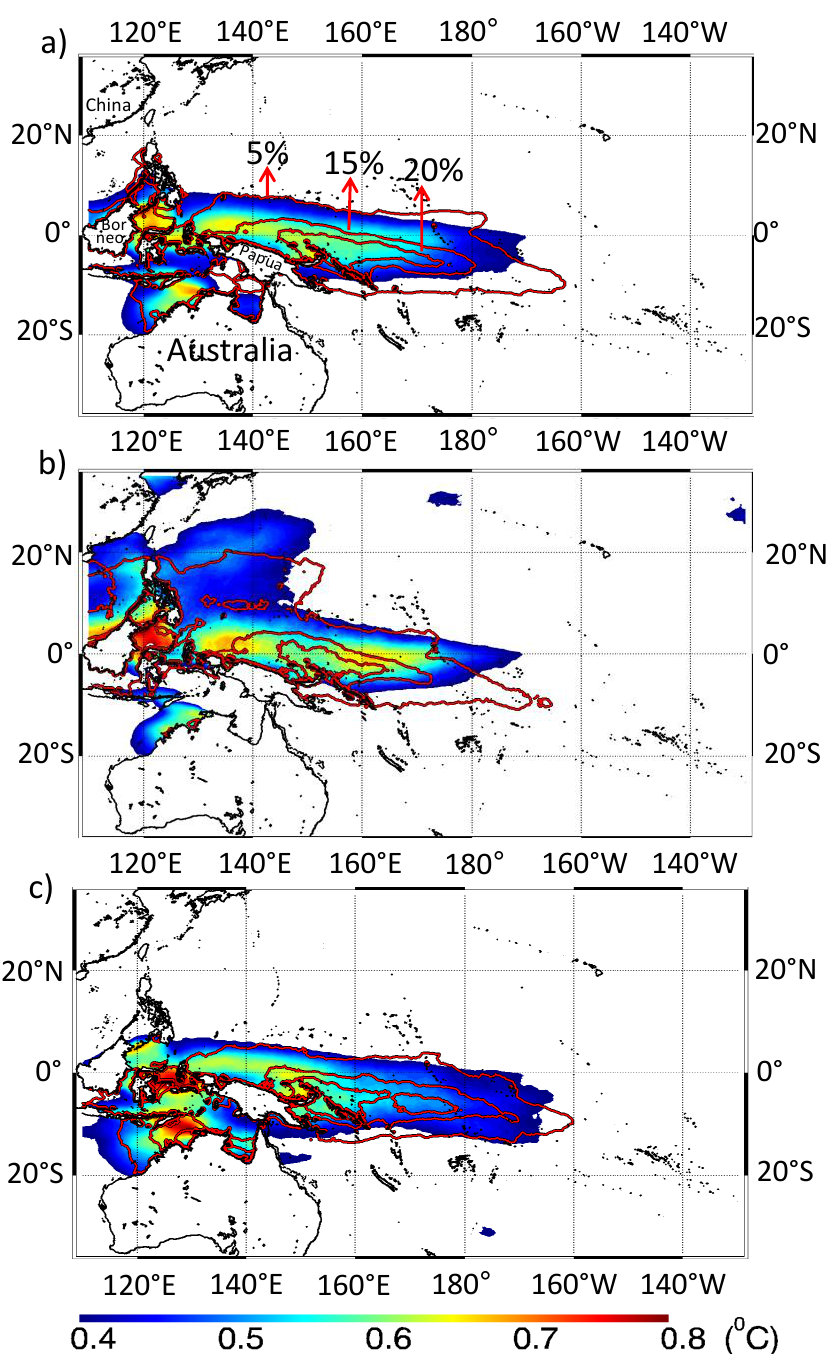
Figure 6. The composite of δ SST map during hot event (HE) period overlaid with the contour of occurrence rates of HEs, shown in frequency per grid (%) during 2003–2011, for ( a ) the whole period (100% is 3163 days; ≈ 9 year period), ( b ) boreal summer (April–September; 100% is 1615 days), and ( c ) boreal winter (October–March; 100% is 1548 days).